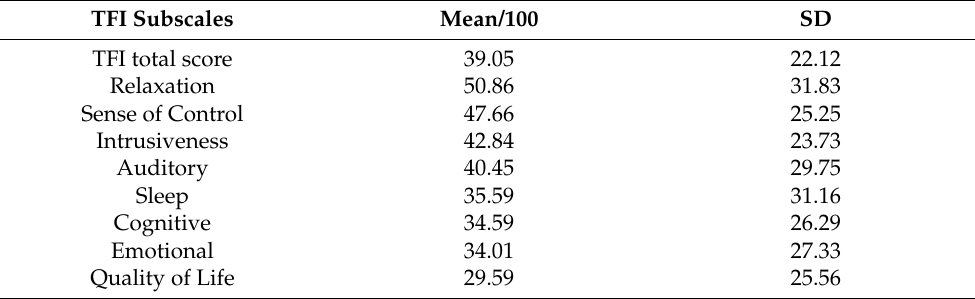
Table 2. Tinnitus functional index (TFI) mean total score and mean subscale scores.